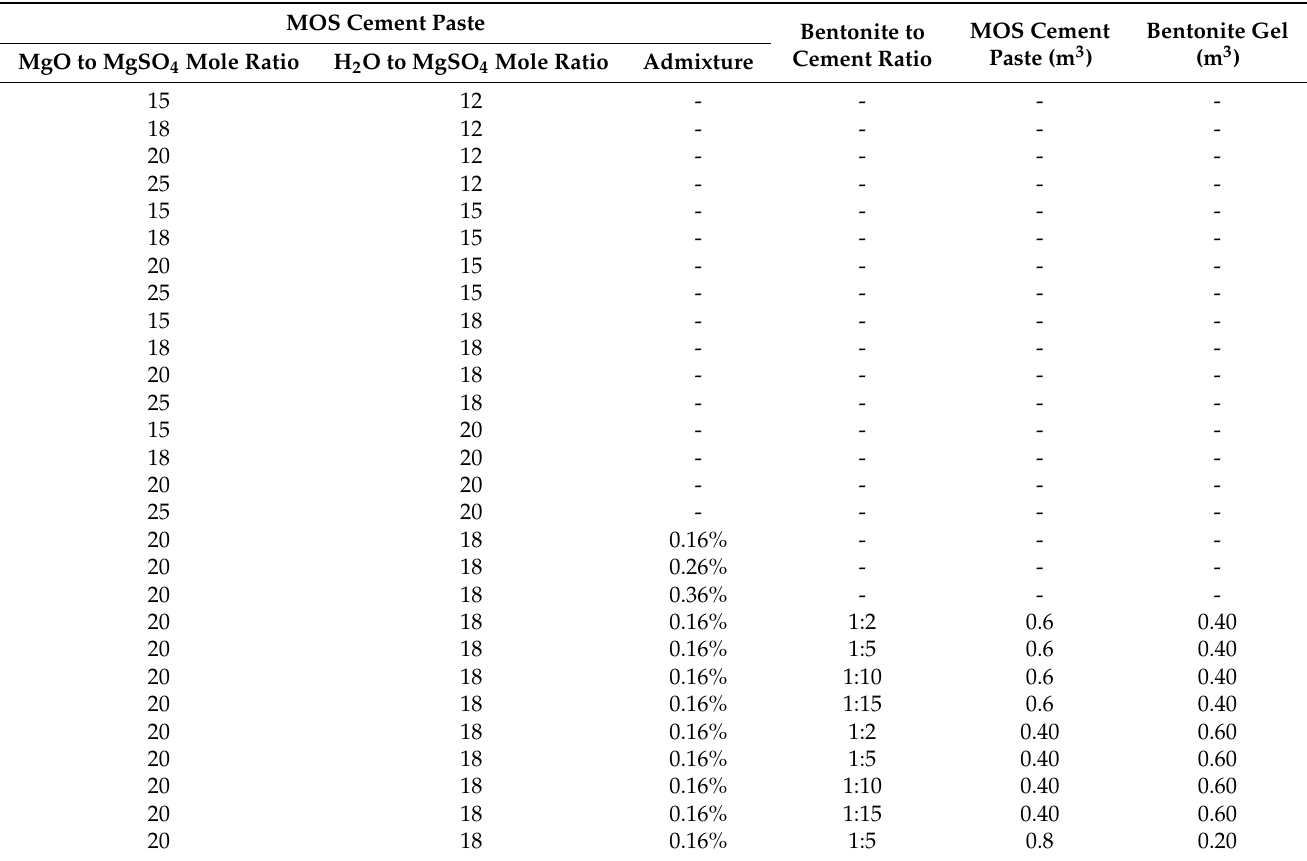
Table 2. Mix parameters of porous MOS cement paste and MOS cement paste. MOS Cement